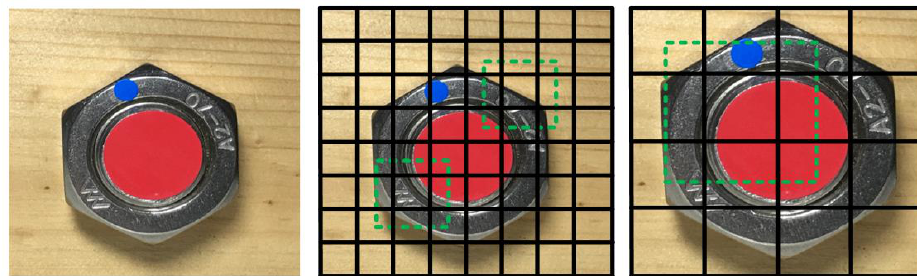
Figure 6. Features in multi-scales. Sensors 2021 , 21 , x FOR PEER REVIEW